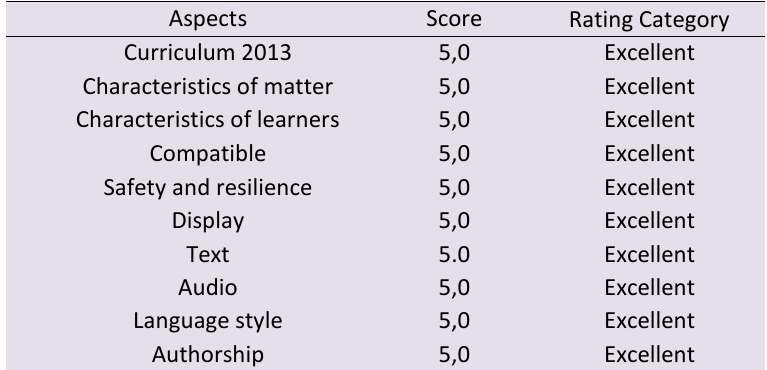
Table 5. Score Results Per Aspect of Classroom